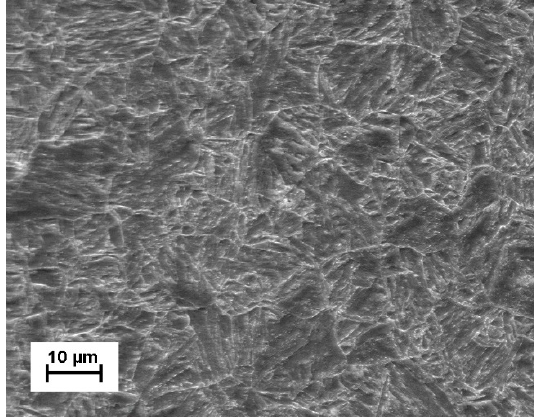
Figure 4. Tempered martensitic microstructure of the base material (M = 1000×, 2% HNO 3 ).